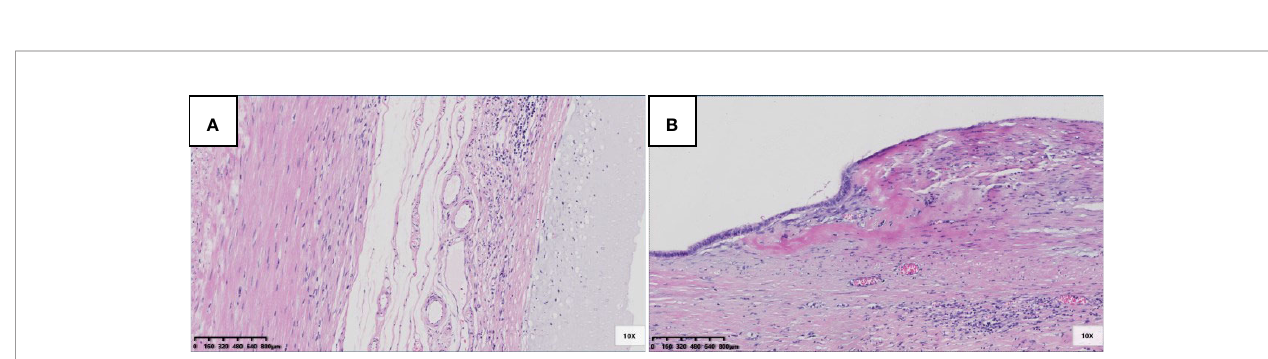
FIGURE 1 | Epithelial structural changes in LAMN. (A) The fl at low-grade mucinous epithelium was directly attached to the inner side of the fi brotic mucosa, and the muscularis propria of the appendix was intact (HE 100×); (B) Undulating or scalloped structures can be found (HE 100×); (C) Filiform villous structures can be found (HE 100×); (D) Serration was found in the background, which had typical crypt architectural features, including serration, dilatation, horizontal orientation, L-shape or inverted T-form (black arrow) (HE 100×).